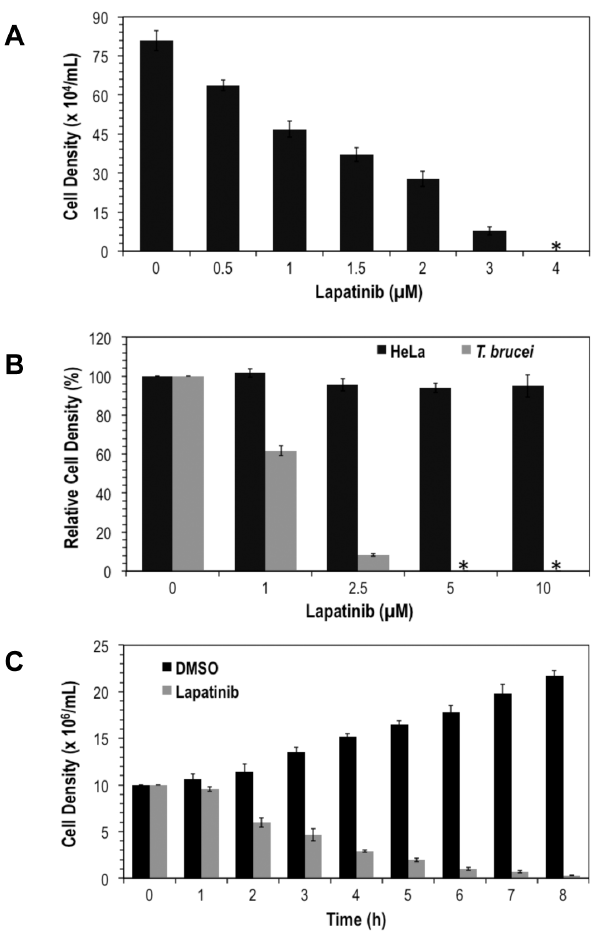
Figure 2. Lapatinib, AEE788 and canertinib kill bloodstream T. brucei . Bloodstream form T. brucei (initial cell density of 2 6 10 3 cells/ml) were cultured in 24-well plates for 48 h with either DMSO (control) or different concentrations of drug. Cells were counted with a hemocy- tometer and the graphs plotted. Data are mean 6 standard deviation obtainedfrom twoindependent experiments performedin duplicate. ( A ). Effect of lapatinib on growth of T. brucei . ( B ). Comparison of growth inhibitory effect of lapatinib on T. brucei to HeLa cells. HeLa and T. brucei cells were cultured for 48 h with variable concentrations of lapatinib. Relative cell density represents the live cells expressed as percentages of the control ( i.e. , DMSO-treated) experiment. ( C ) Trypanosome kill assay. Time-course of trypanocidal effect of lapatinib. Trypanosomes (10 6 cells/ ml) were treated with DMSO (solvent) or lapatinib (10 m M) for 8 h: viable cells were counted every hour, and plotted for each time